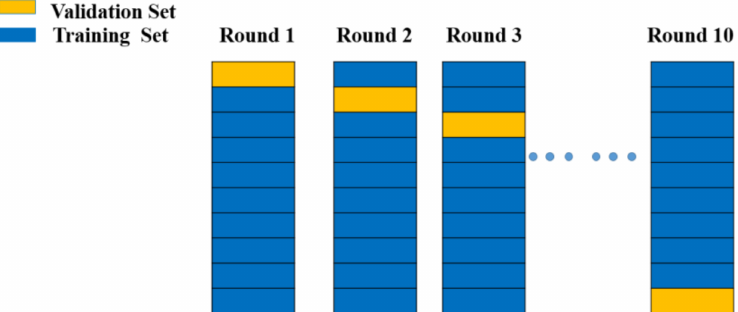
Figure 14. Cross-validation model diagram from Round 1 to Round